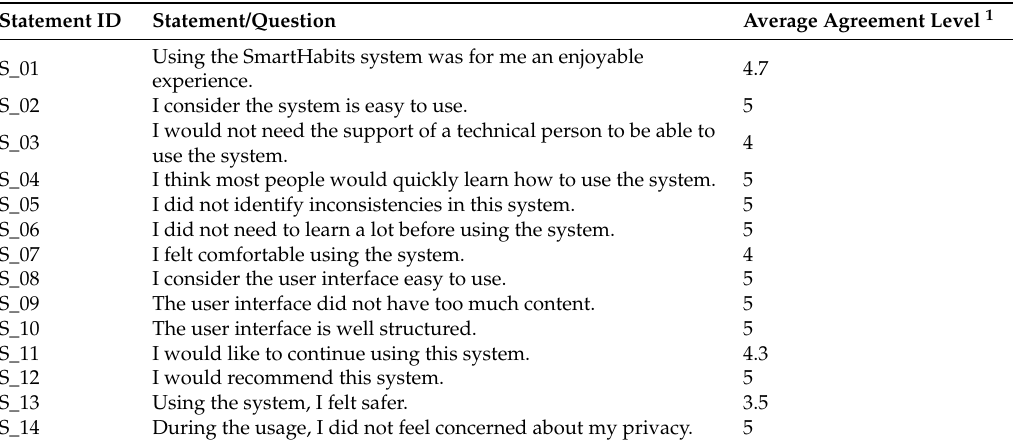
Table 4. End-user questionnaire and